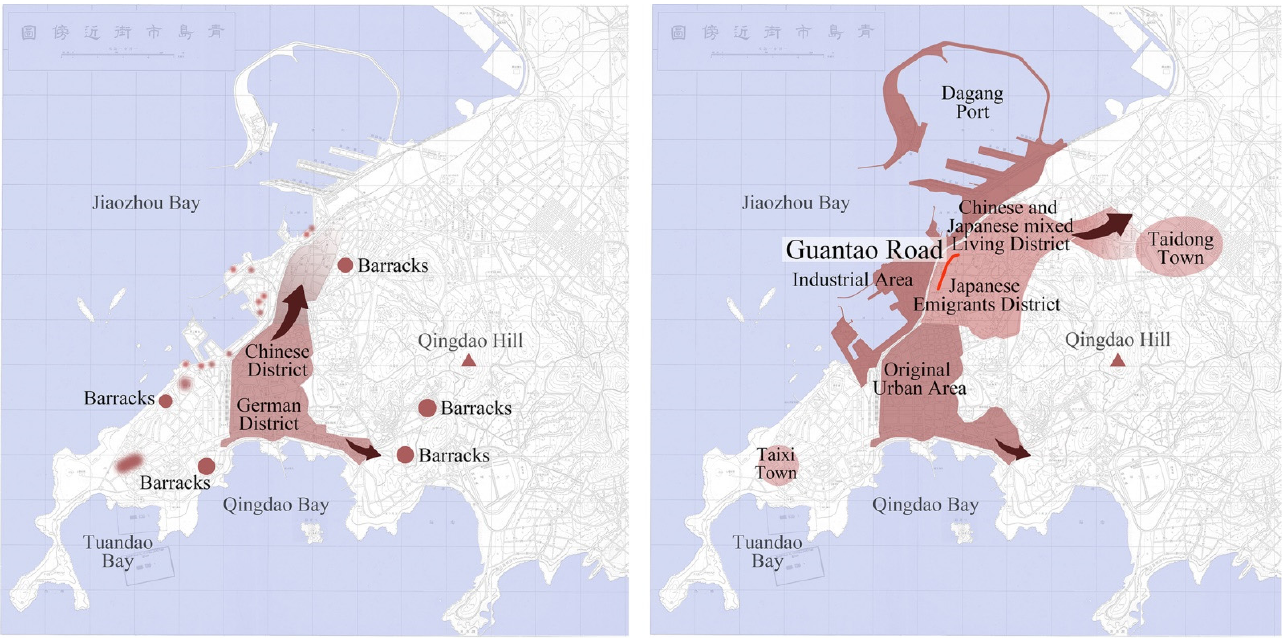
Figure 5. Development of Qingdao City from 1898 to 1922.